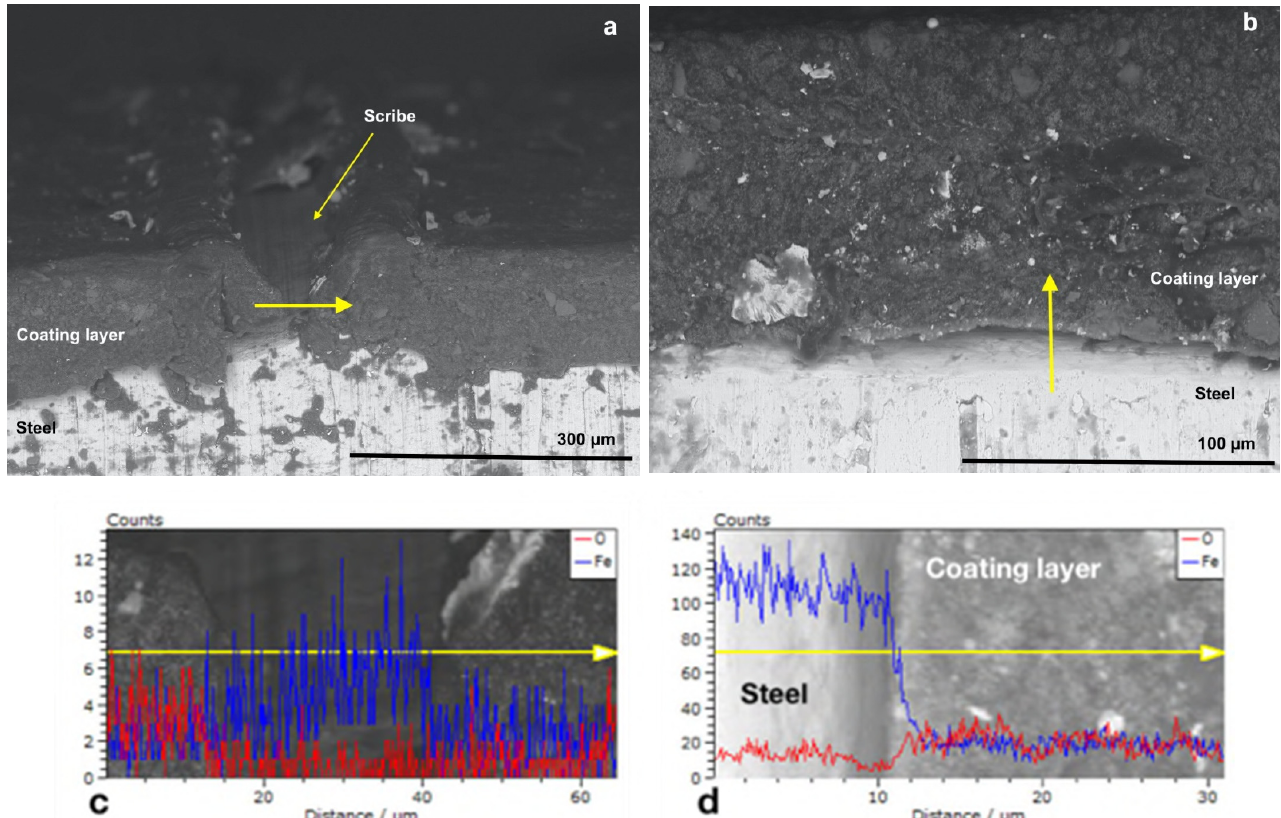
Figure 5. SEM micrographs with EDX linescan ( c , d ) of the cross-section of P_SA40_T60 U coated specimens at ( a ) the scribe and at ( b ) no-scribed region. Red and blue spectra correspond to O and Fe, respectively.